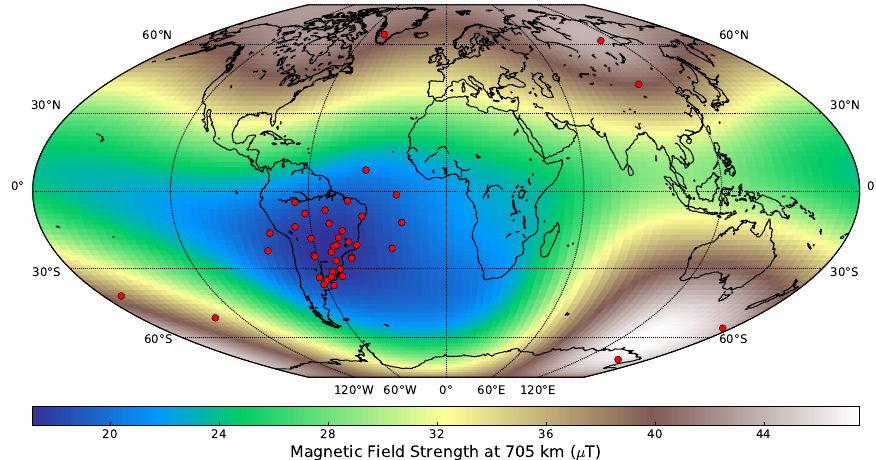
Figure 8. A map of the geolocation of the instrument (red dots) for each significant change in the crosstalk coefficients as determined by the scan-by-scan gain change on-orbit (Figure 7). The colormap shows the magnetic field strength at the nominal altitude of the Terra spacecraft (705 km) in µ T. Most of the events occur in the South-Atlantic Anomaly, which is a region of relatively low magnetic field